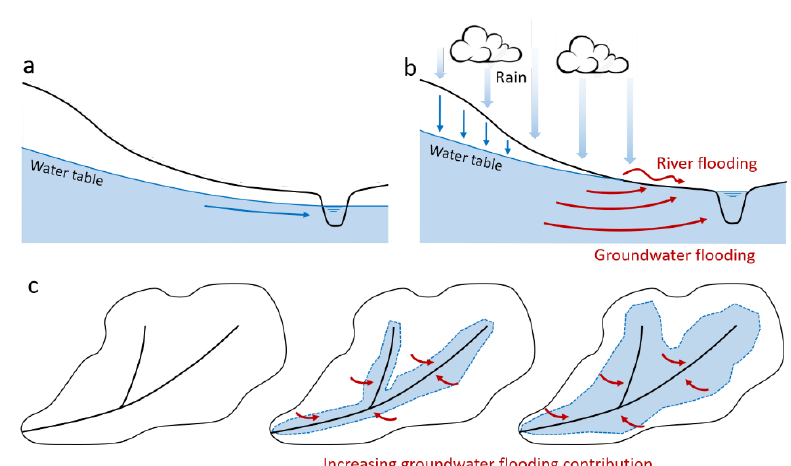
Figure 2. Sketch of the groundwater flooding mechanism. ( a ), Flow in the absence of rain where the water table is lowered by pumps, is altered by rainfall; ( b ) the latter determines an increase of the water table and ( c ) consequent increase of contributing areas near the channels.